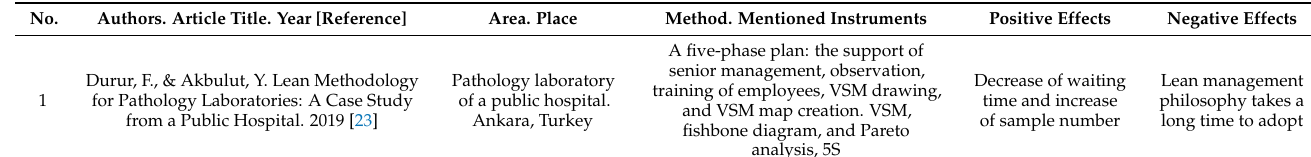
Table 1. WoS papers focused on LSS implementation in medical